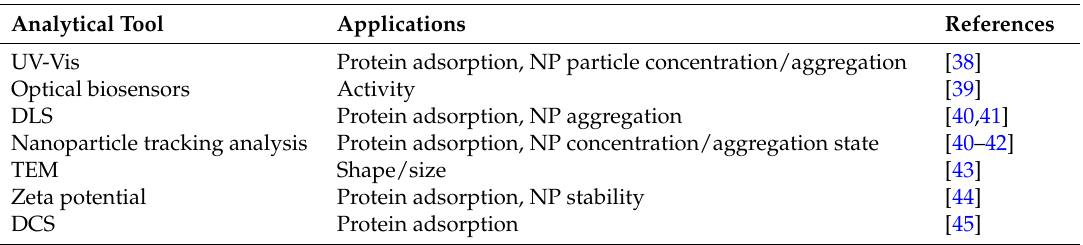
Table 2. Analytical tools for the characterization of nanoparticles. UV-Vis, ultraviolet-visible; TEM, transmission electron microscopy; DCS, differential centrifugal sedimentation.